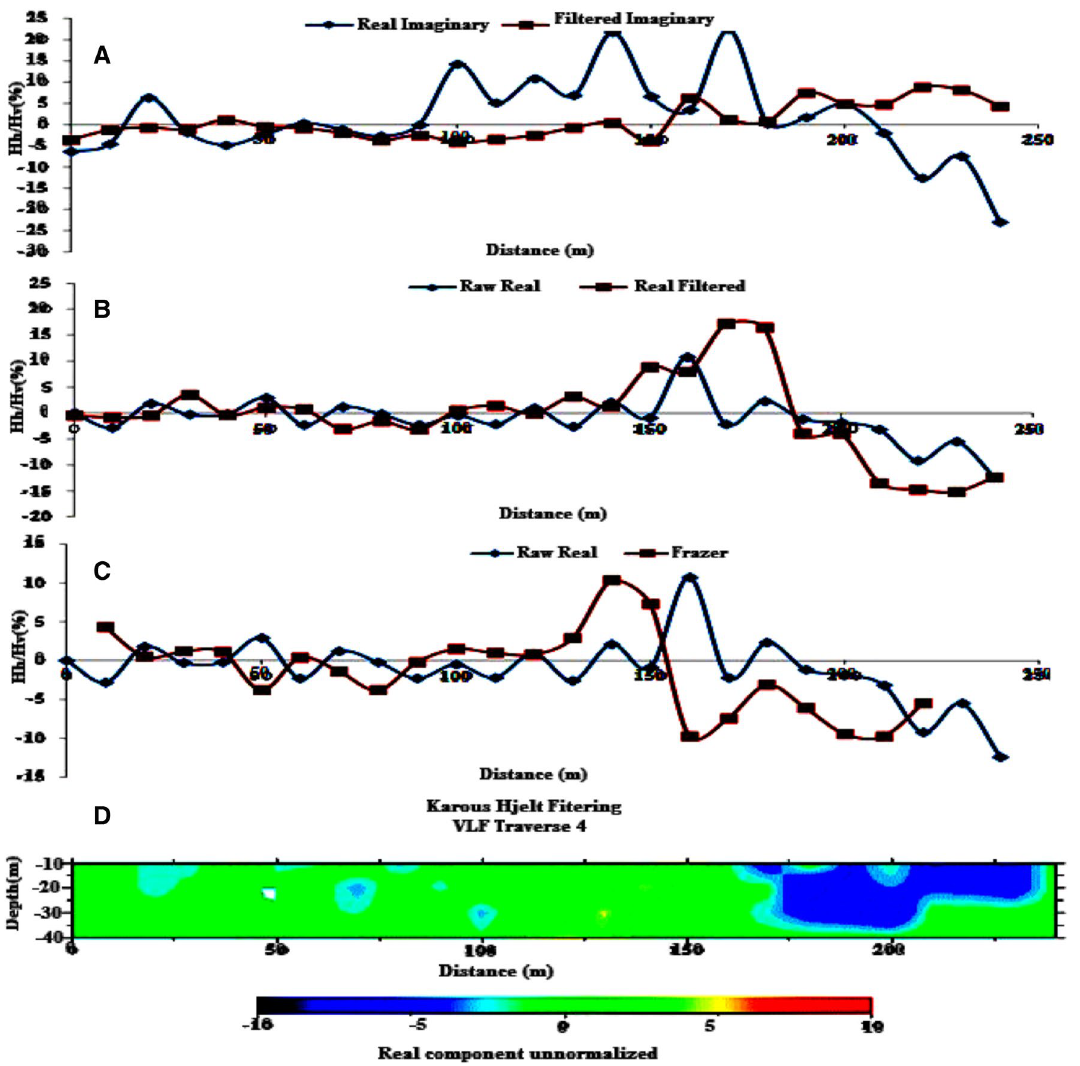
Fig. 5 VLF-EM profile 1 along north–south direction a Plot of raw and filtered imaginary against distance b Plot of imaginary raw and filtered against distance c Frazer filtering against distance d Pseudosection of the inverted real component,